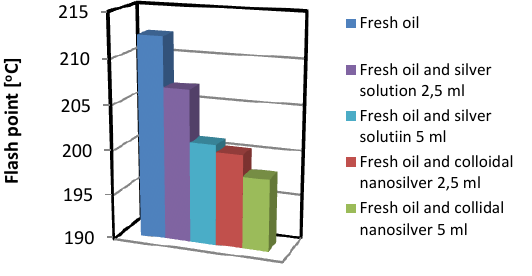
Fig. 11. Flash point oil of used oil and used oil with EM in liquid form and ceramic tubes